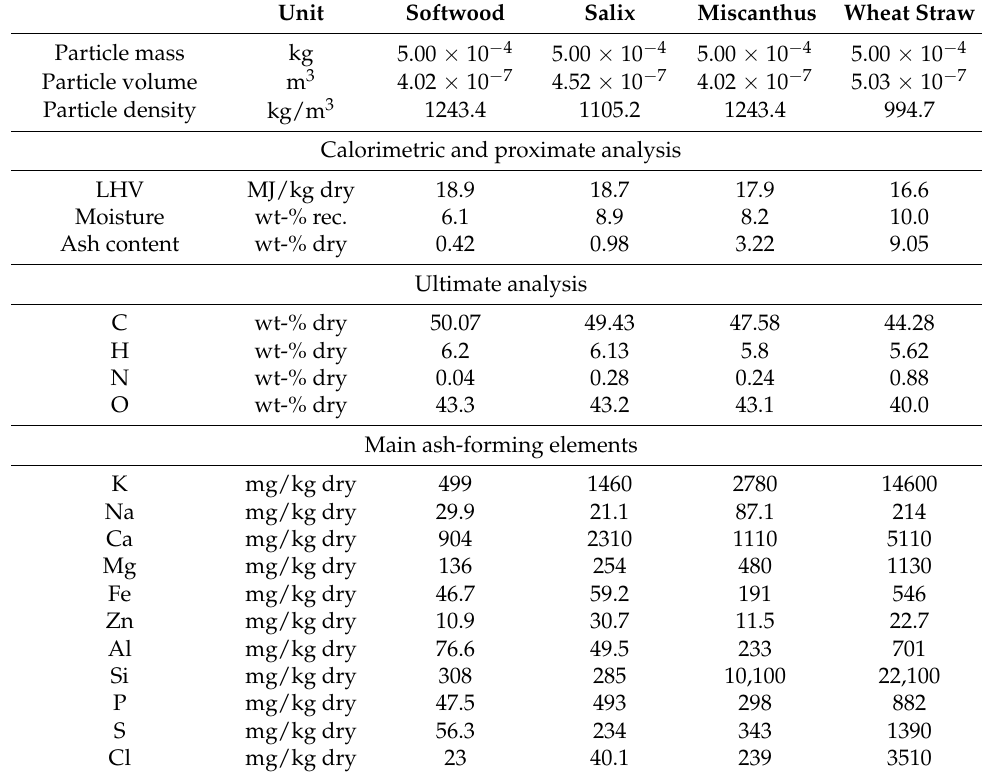
Table 1. Physical and chemical properties, including fuel analysis, of softwood, Salix, Miscanthus and wheat straw biomass particles. Unit Softwood Salix Miscanthus Wheat